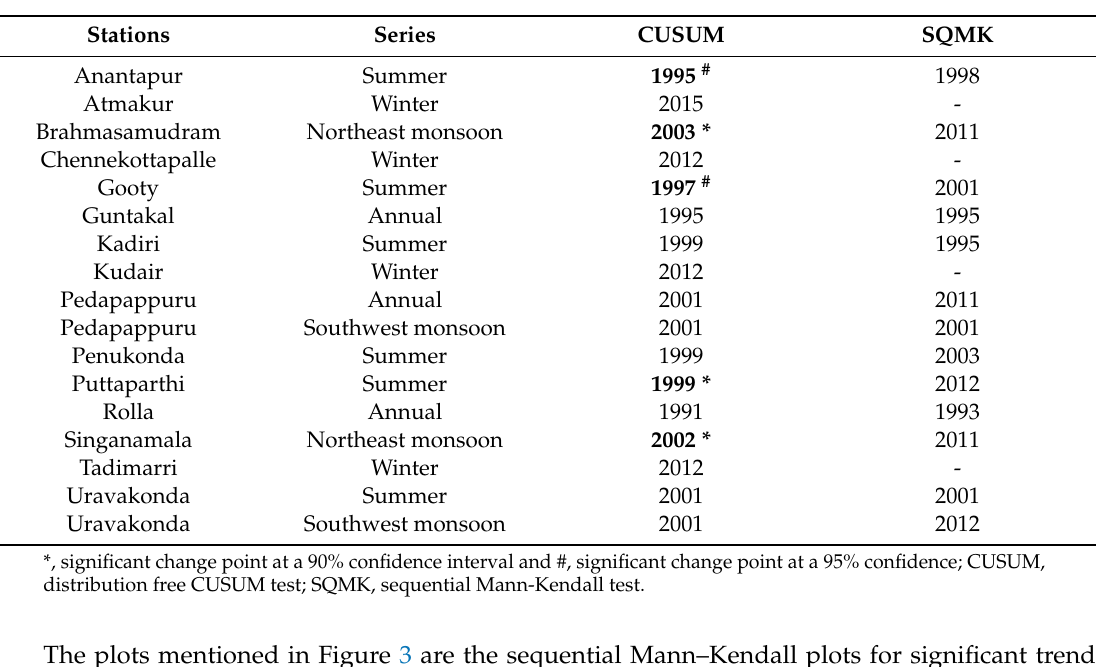
Table 5. Trend change point summary.